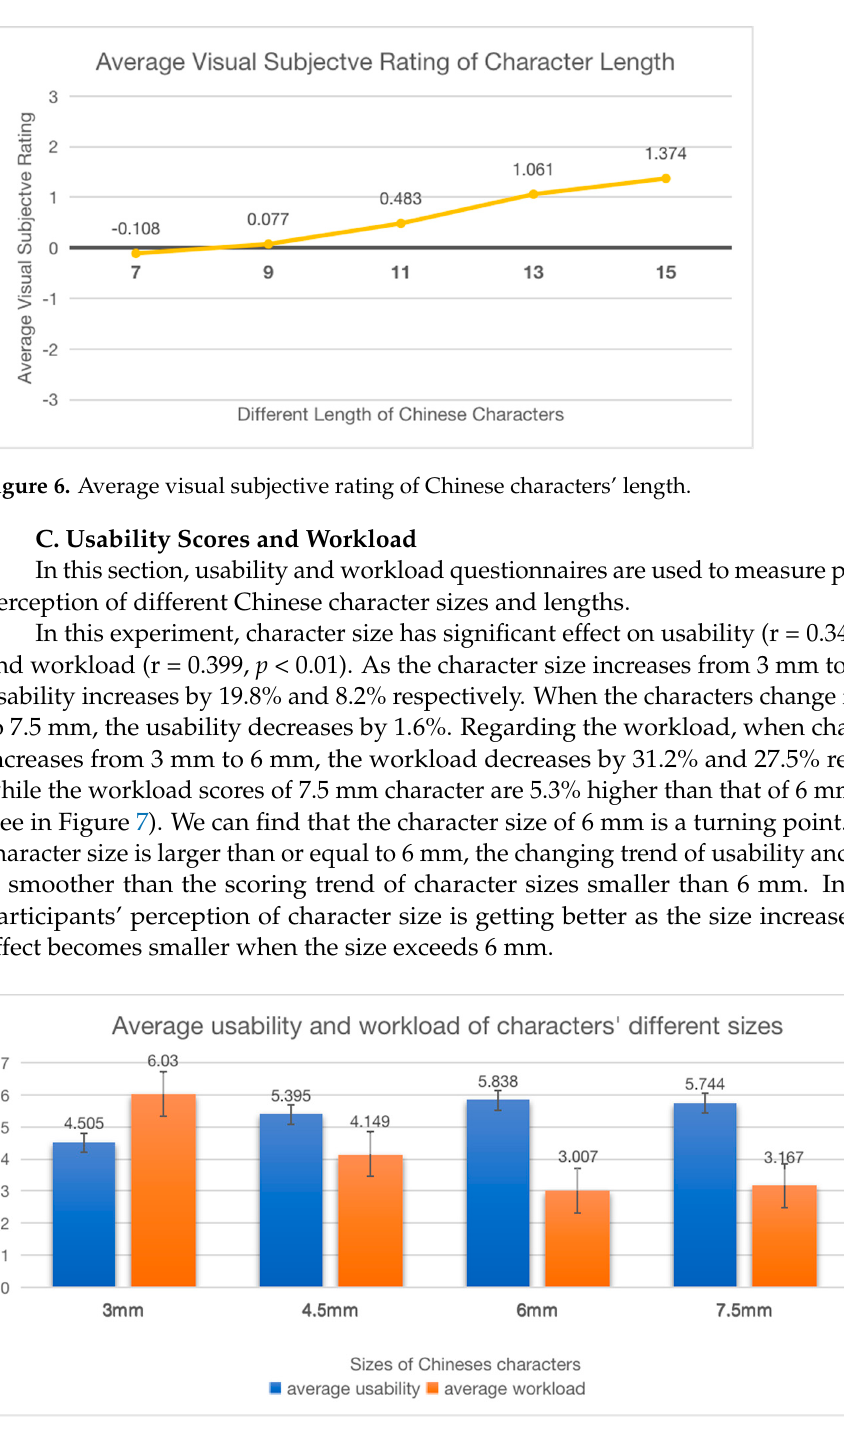
Figure 5. Average visual subjective rating of Chinese characters’ sizes.